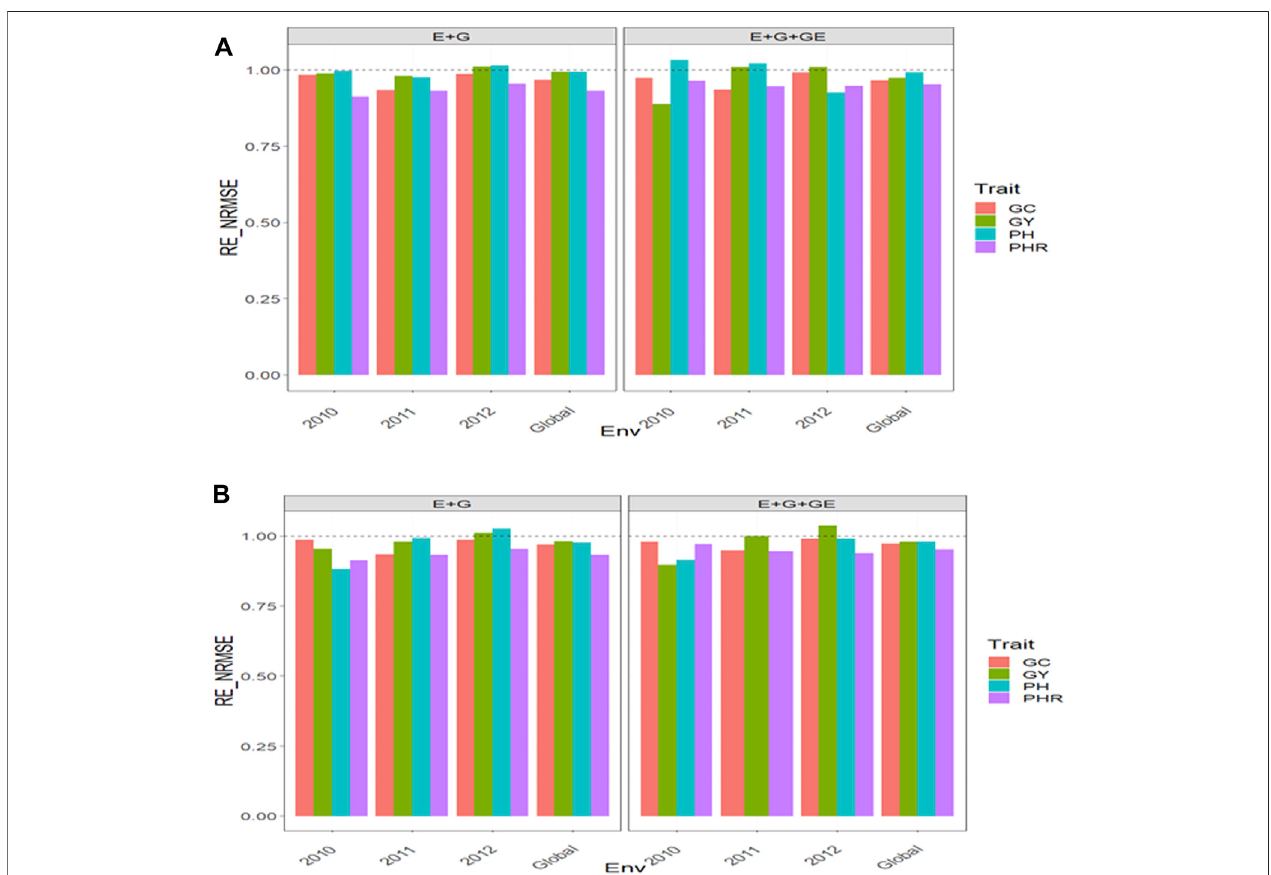
FIGURE 8 | Relative ef fi ciency in terms of normalized root mean square error (RE_NRMSE) computed by dividing the NRMSE under the best linear unbiased predictor model (GBLUP) between the NRMSE of the partial least squares regression method. Prediction performance is reported for each environment and across environments(Global)indataset13(Indica),alsowithtwopredictors(E+GandE+G+GE).WhentheRE_NRMSE > 1,thePLSoutperformstheGBLUPmethodinterms of prediction performance (lower NRMSE). (A) With environmental covariates (EC) and (B) without